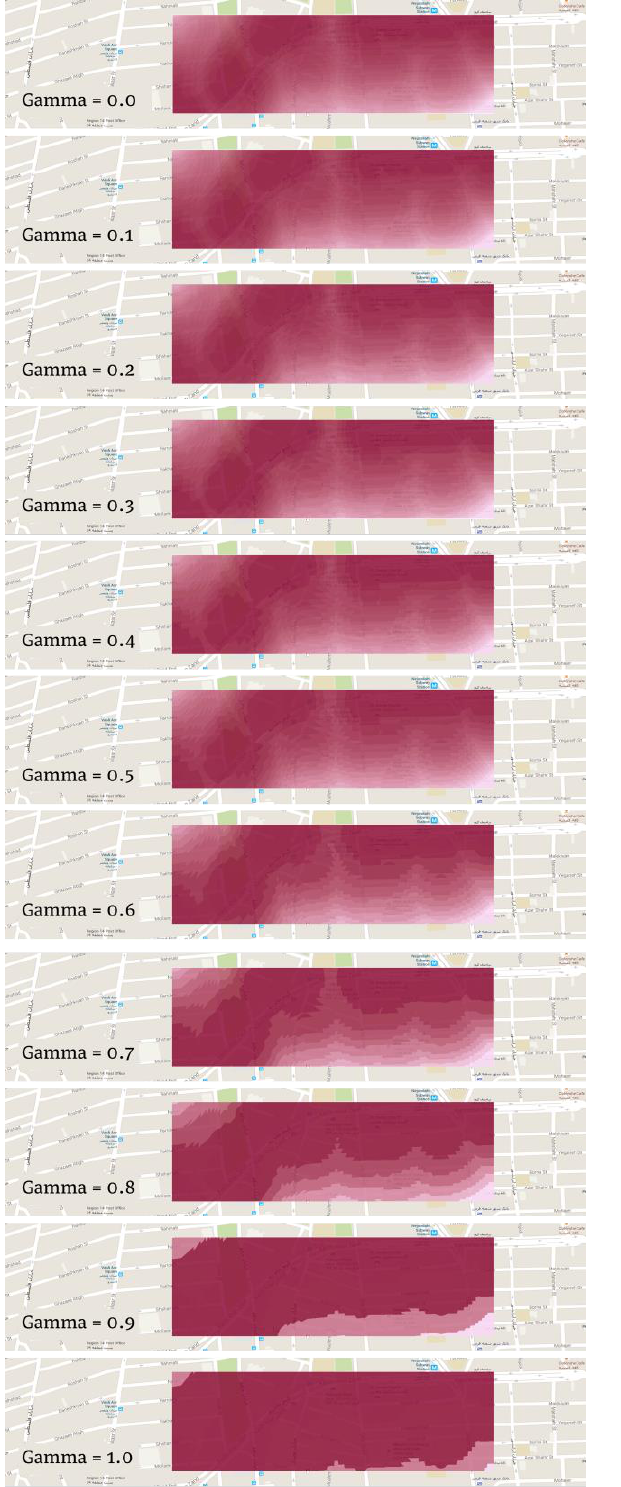
Figure 11. Different Outputs for Different γ (from 0 to